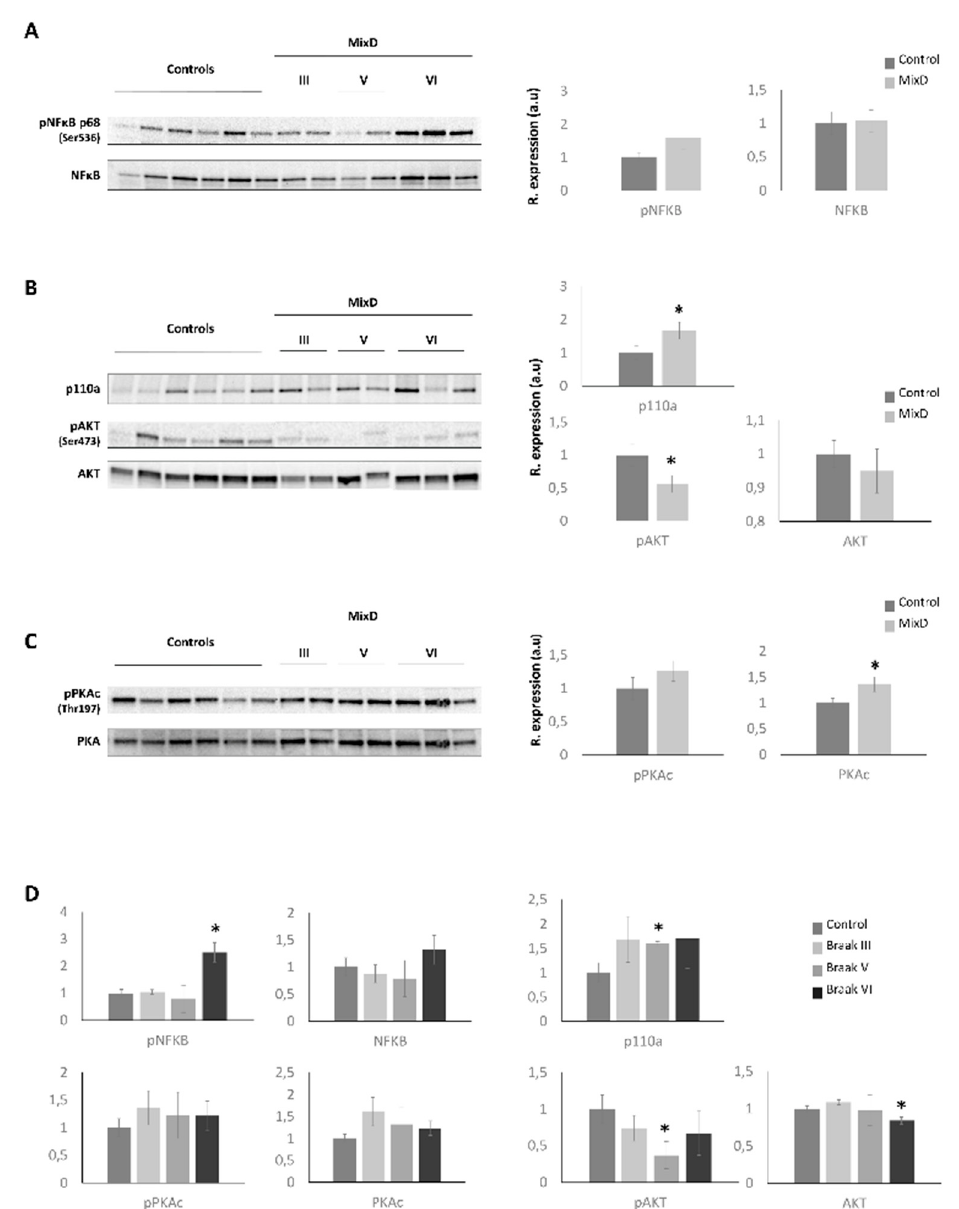
Figure 4. Monitoring of the specific signaling modulators that appeared as principal nodes in our protein interactome maps. Levels and phosphorylation of NF κ B ( A ), p110a, AKT ( B ), and PKAc ( C ) were analyzed across MixD OB samples. Analysis was also performed separating MixD group by Braak staging ( D ). (* p < 0.05 versus control group).